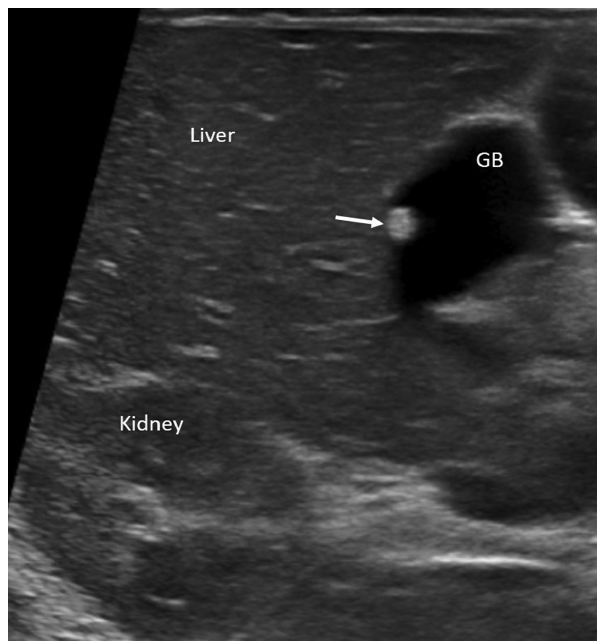
Figure 1. Transverse abdominal US of the gallbladder (case number 8) shows an echogenic polyp (arrow) in the gallbladder. GB, gallbladder; US, ultrasonography.